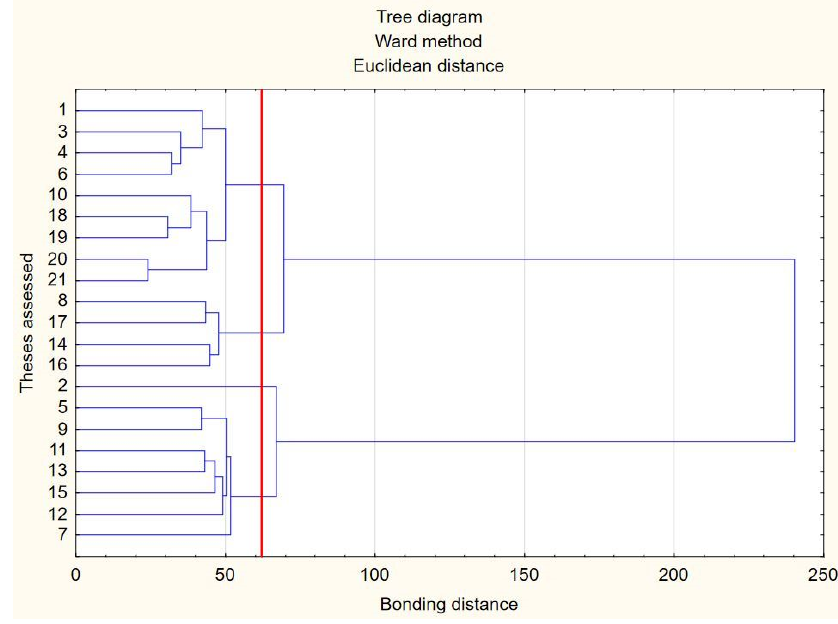
Figure 4. Cluster analysis dendrogram.